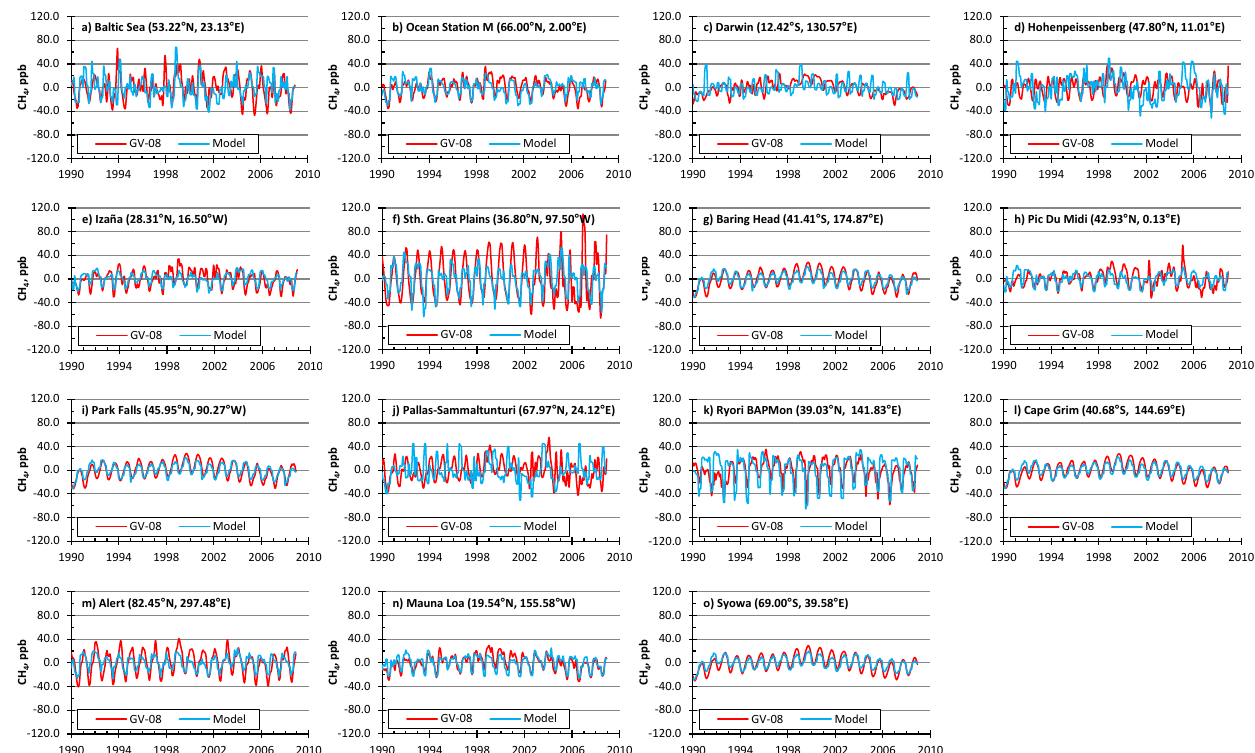
Fig. 5. Detrended seasonal cycle of surface CH 4 volume mixing ratio for GLOBALVIEW stations (corresponding TCCON stations in parentheses): (a) Baltik See (Bialystok); (b) Ocean Station M (Bremen); (c) Darwin (Darwin); (d) Hohenpeissenberg (Garmisch); (e) Iza ˜ na (Iza˜na); (f) Southern Great Plains (Lamont); (g) Baring Head Station (Lauder); (h) Pic Du Midi (Orleans); (i) Park Falls (Park Falls); (j) Pallas-Sammaltunturi (Sodankyl¨a); (k) Ryori (Tsukuba); (l) Cape Grim (Wollongong); (m) Alert; (n) Mauna Loa; and (o)